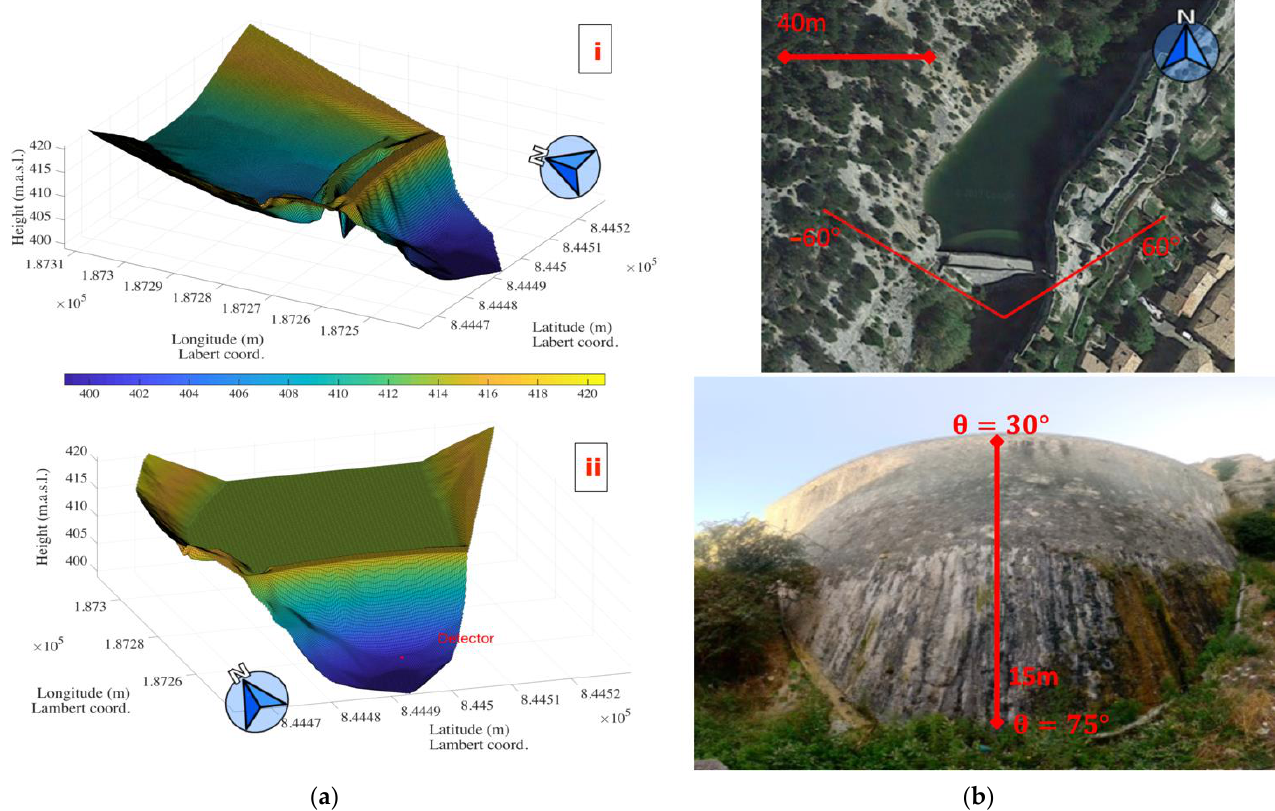
Figure 4. ( a ). (i) Digital model of the empty water reservoir and ( a ). (ii) filled with water at 414 m.a.s.l. ( b ) Approximation of the target volume as seen from the detector location.